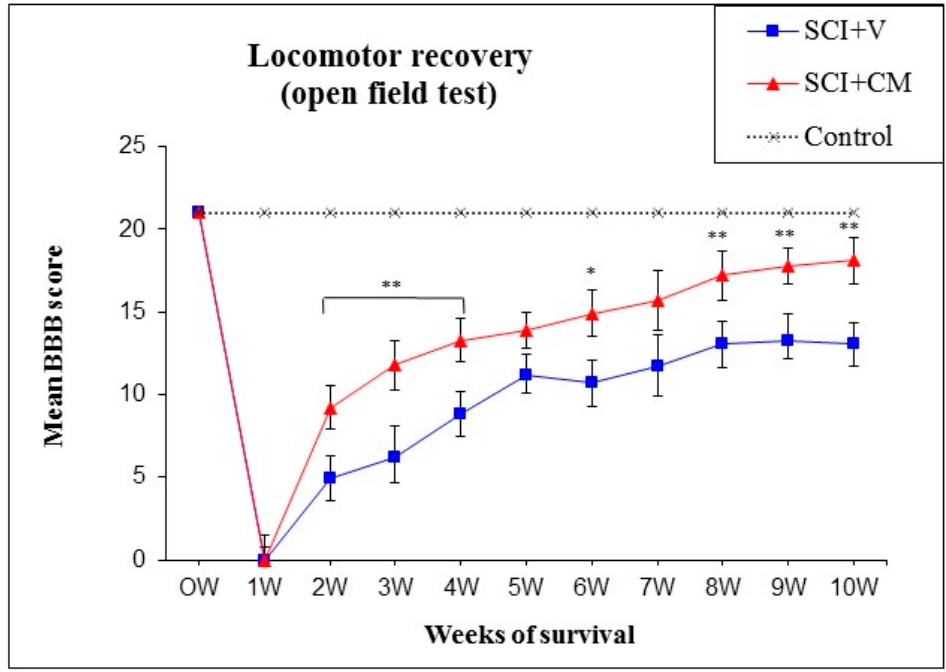
Figure 3. Functional recovery of hindlimb motor function following spinal cord injury (SCI) treated with MScCM (SCI + CM, n = 6) and vehicle (SCI + V, n = 4). * p < 0.05, ** p < 0.01 indicate significant differences between groups during ten weeks, respectively.